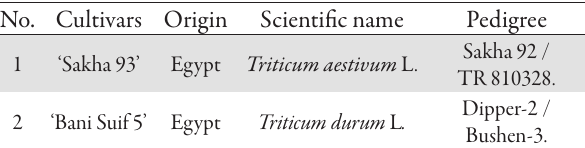
Tab. 2. Pathogenic ability of four soil borne fungi on damping-off and root rot severity of wheat plants under